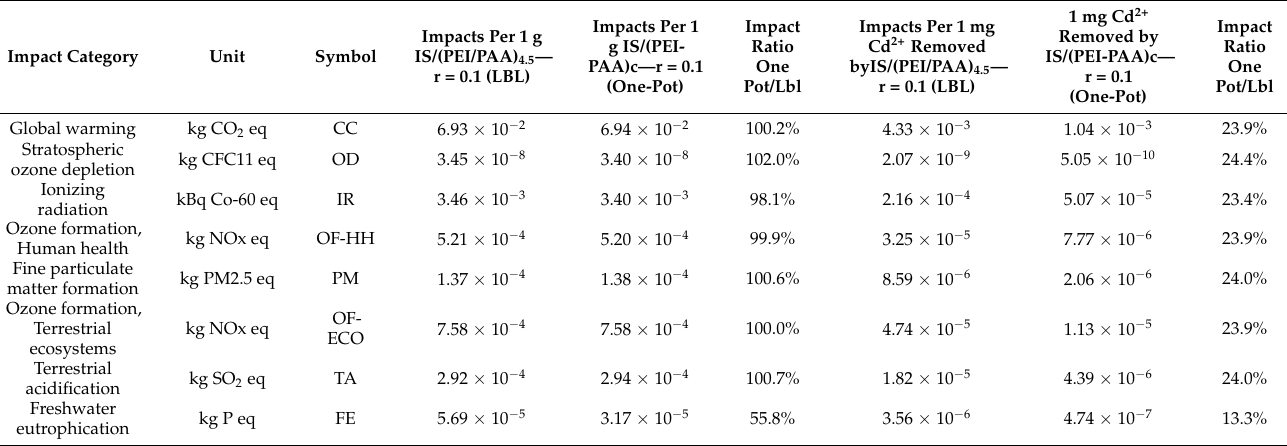
Table 3. Environmental impacts of composite silica/PEI materials (per functional